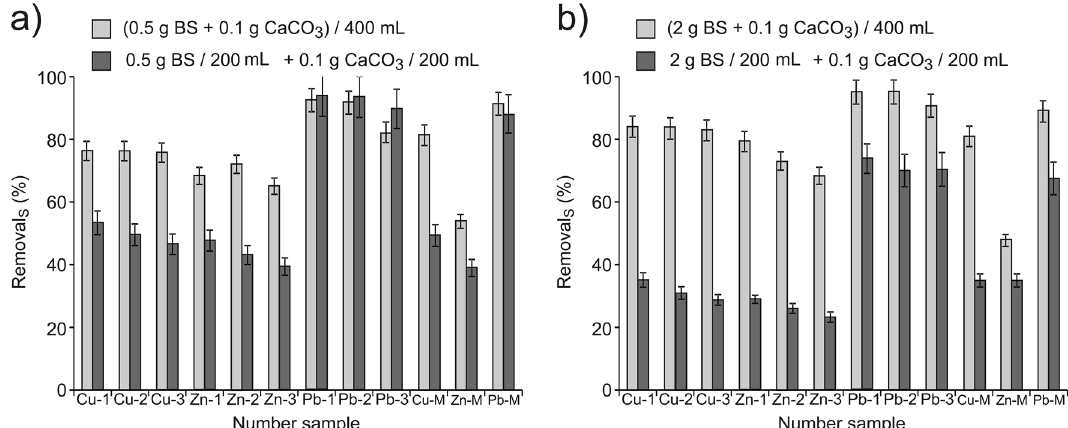
Figure 5. Efficiency of metal cation removal with the use of BS and CaCO 3 , in variants: together light gray and separately dark gray; ( a ) using Pleurozium Schreberii mosses ( b ) using P-BSG.